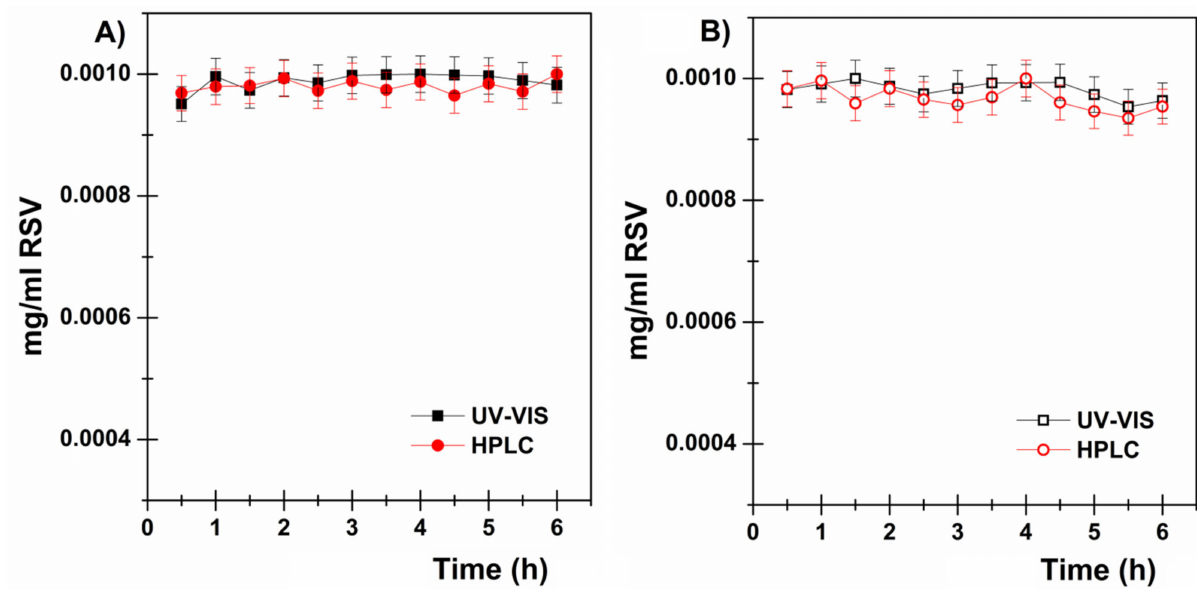
Figure 1. RSV stability studies on ( A ) the citrate buffer (pH 5.5) and PEG 200 mixture (80:20 v / v ) and ( B ) also in presence of NAC (RSV: NAC = 1:2). RSV was quantified by UV-Vis (black) and HPLC (red) analyses. Results are presented as means ± SE ( n =